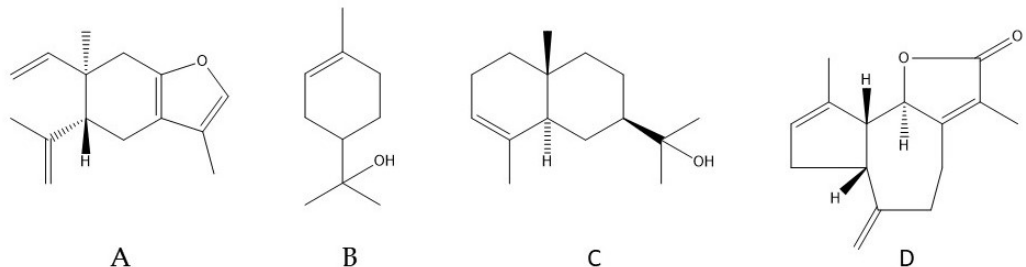
Figure 4. Chemical structures of the main compounds found in the active fractions of H. brasiliense essential oils: curzerene ( A ); α -terpineol ( B ); α -eudesmol ( C ); and ferula lactone I ( D ).